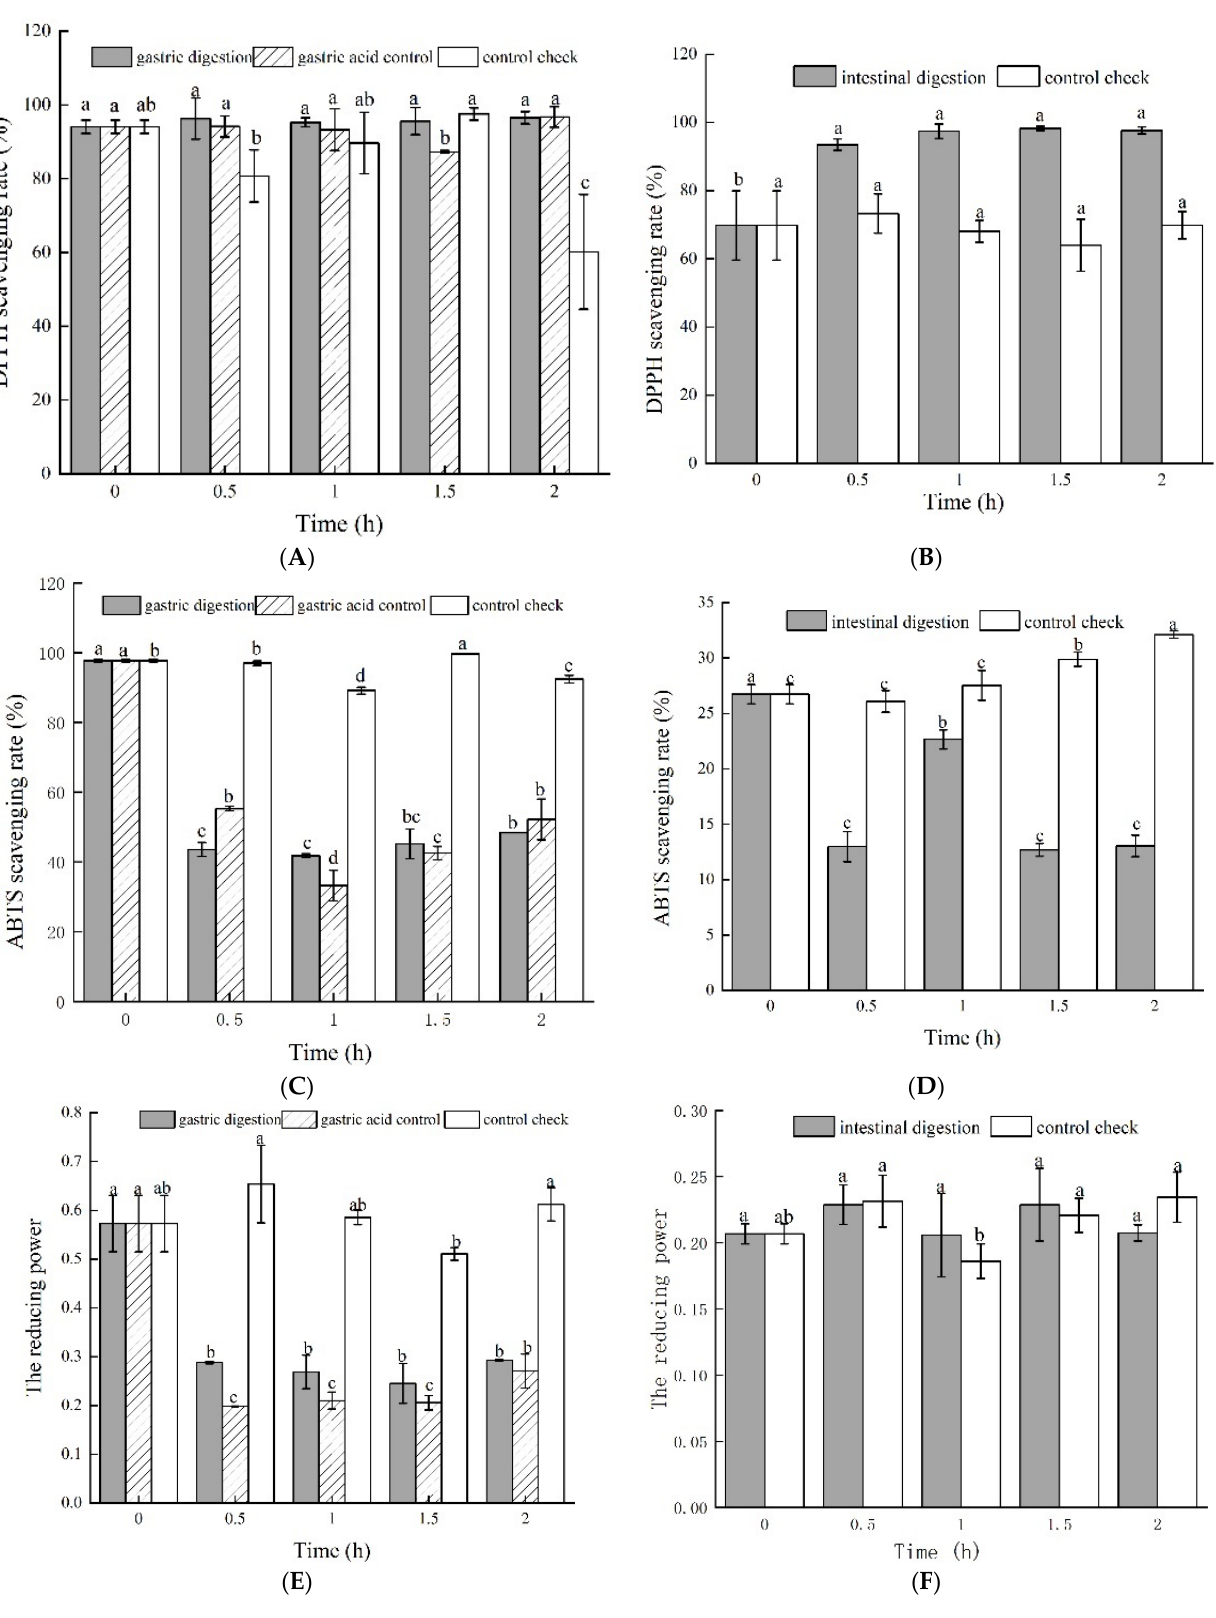
Figure 2. Antioxidant activity of green jujube vinegar during in vitro gastrointestinal digestion, ( A , B ) DPPH radical scavenging rate; ( C , D ) ABTS radical scavenging rate; ( E , F ) reducing power.